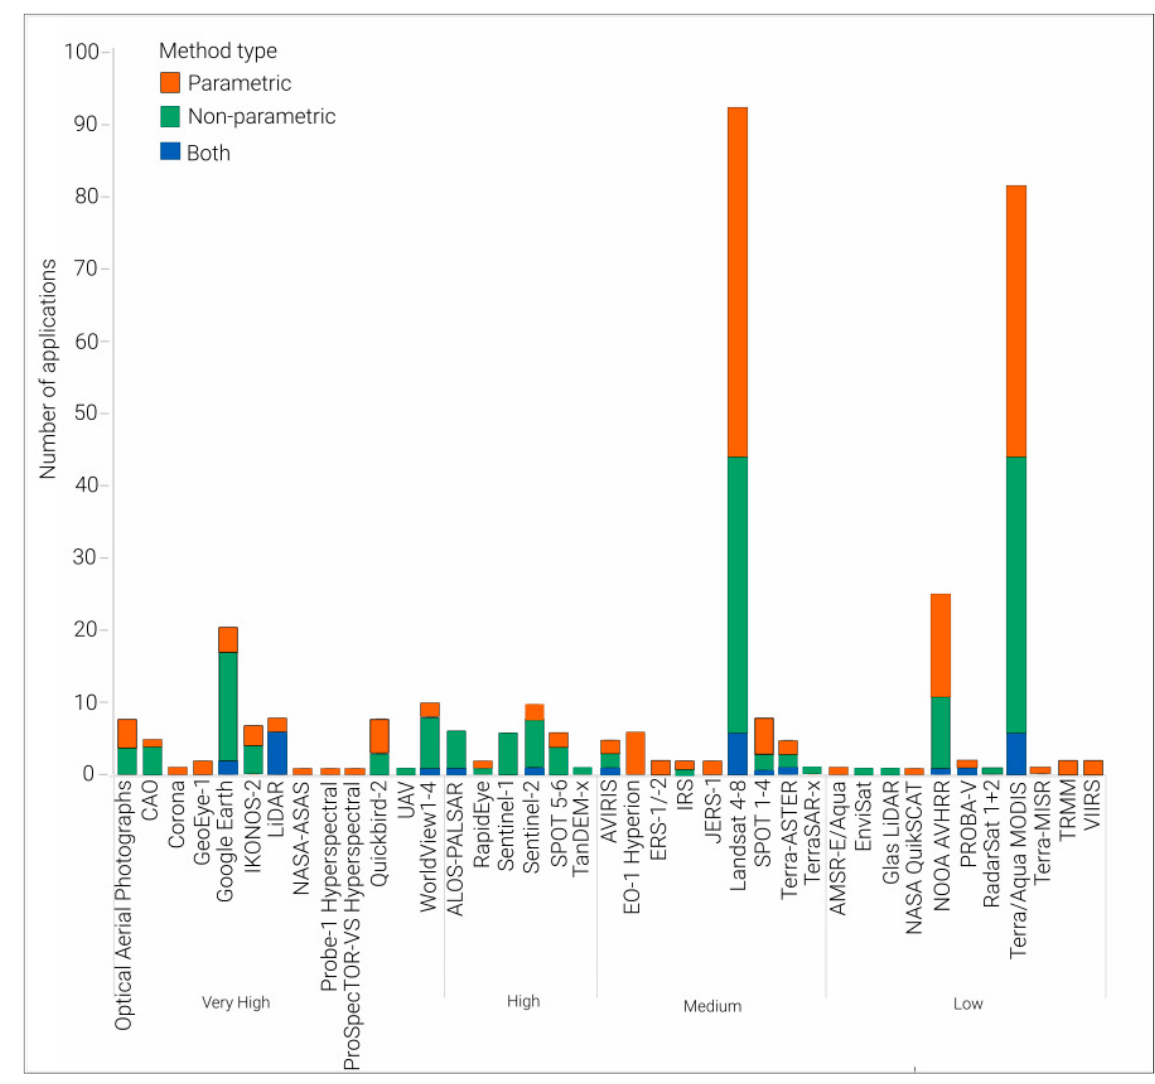
Figure 9. Overview of the method types applied per employed earth observation data. The earth observation data are presented with respect to the spatial resolution.